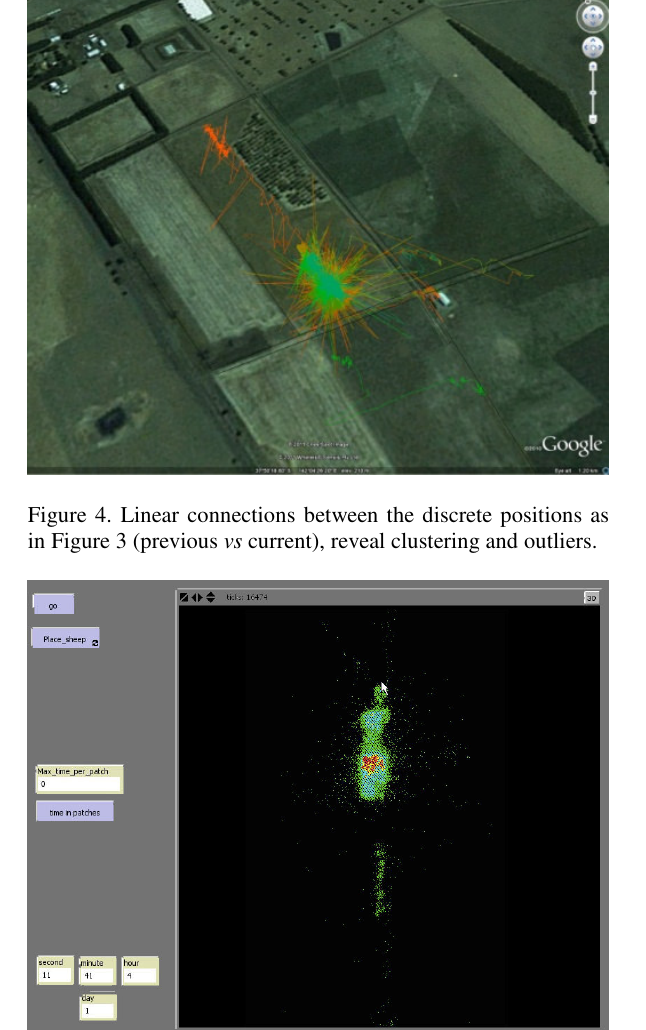
Figure 5. Screen image of preferred feeding sites from a prototype agent-based model using NetLogo